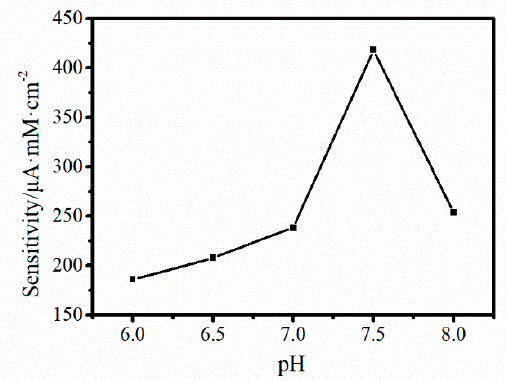
Figure 9. The sensitivity of 3D Au-rGO/FTO to nitrite against pH.